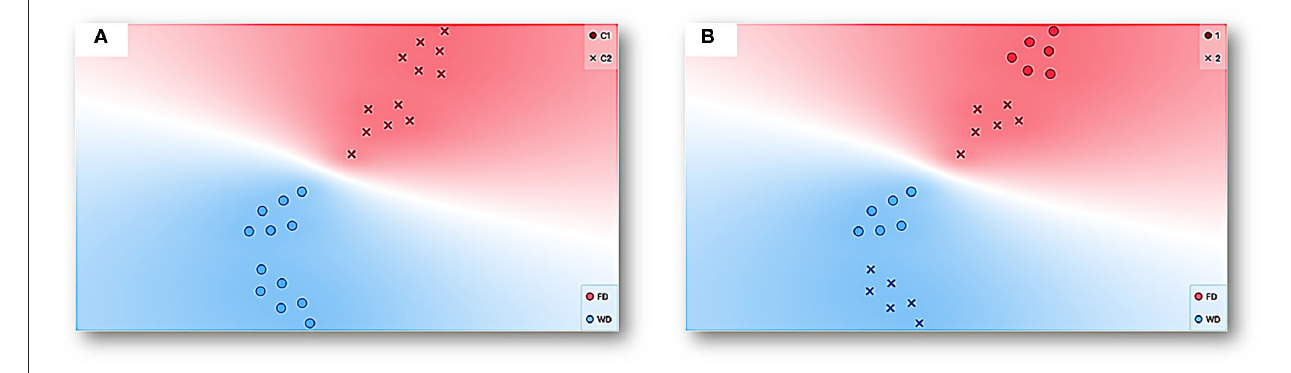
FIGURE 12 | Representation with t-SNE for the data of all experimental sessions and subjects. Each point represents multidimensional data for a session given all features (see Figure 11 ) with deprivation condition, FD (red) and WD (blue), as a target feature. The data with similar values given the multiple features or input variables taken as a whole is simply closer to each other than data with dissimilar values. (A) additionally shows clustering under the K-means procedure and two well-delimitated colored regions with a clear separation between FD and WD data and corresponding each one with a cluster (C1 circles and C2 crosses). On the other hand, (B) depicts the deprivation sequence (Sequence 1 circle and Sequence 2